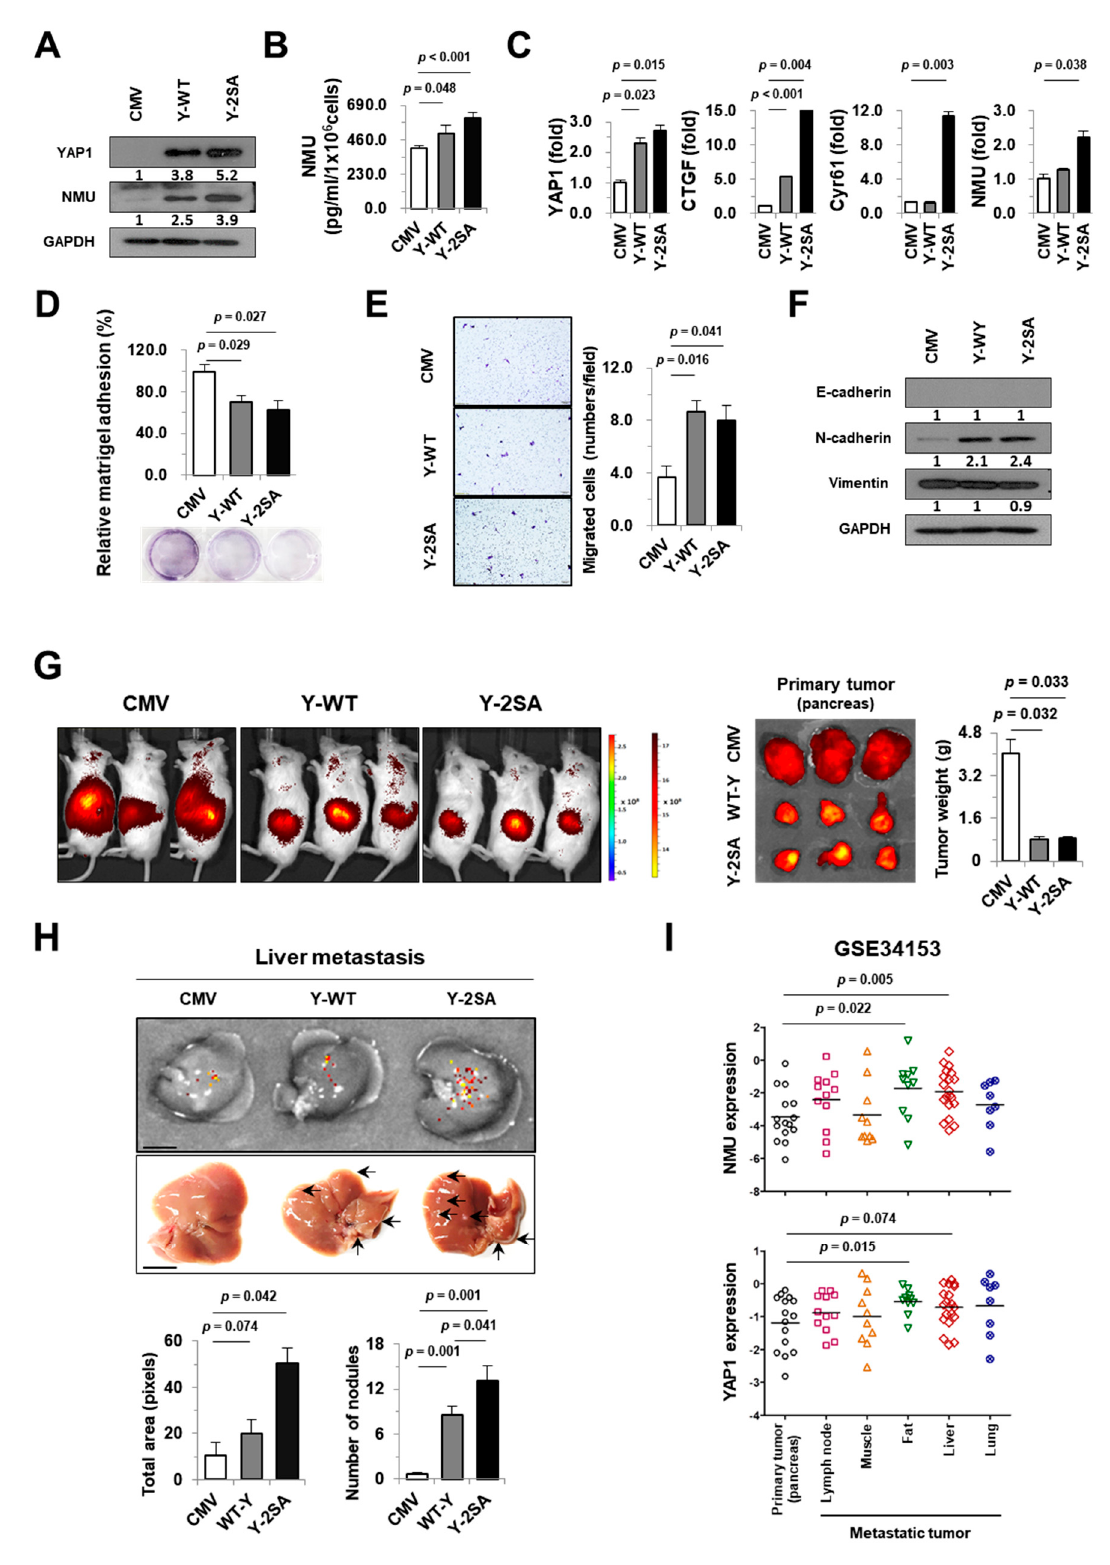
Figure 3. YAP1 overexpression promotes NMU expression and correlates with liver metastasis in vitro and in vivo. ( A ) Western blot analysis of YAP1 and NMU in the indicated cells. Y-WT: cells overexpressing wild-type (WT) YAP1), Y-2SA: cell overexpressing constitutively active YAP S217/381A. ( B ) Concentration of secreted NMU in the culture medium from MIA PaCa-2 cells. ( C ) Changes in YAP1, YAP1-target genes, and NMU mRNA expression assessed by real-time qPCR. ( D ) Cell adhesion analysis. Adherent cells were stained and counted, and the proportion of stained cells was expressed as a percentage with respect to the control. ( E ) Migration ability assessed by the